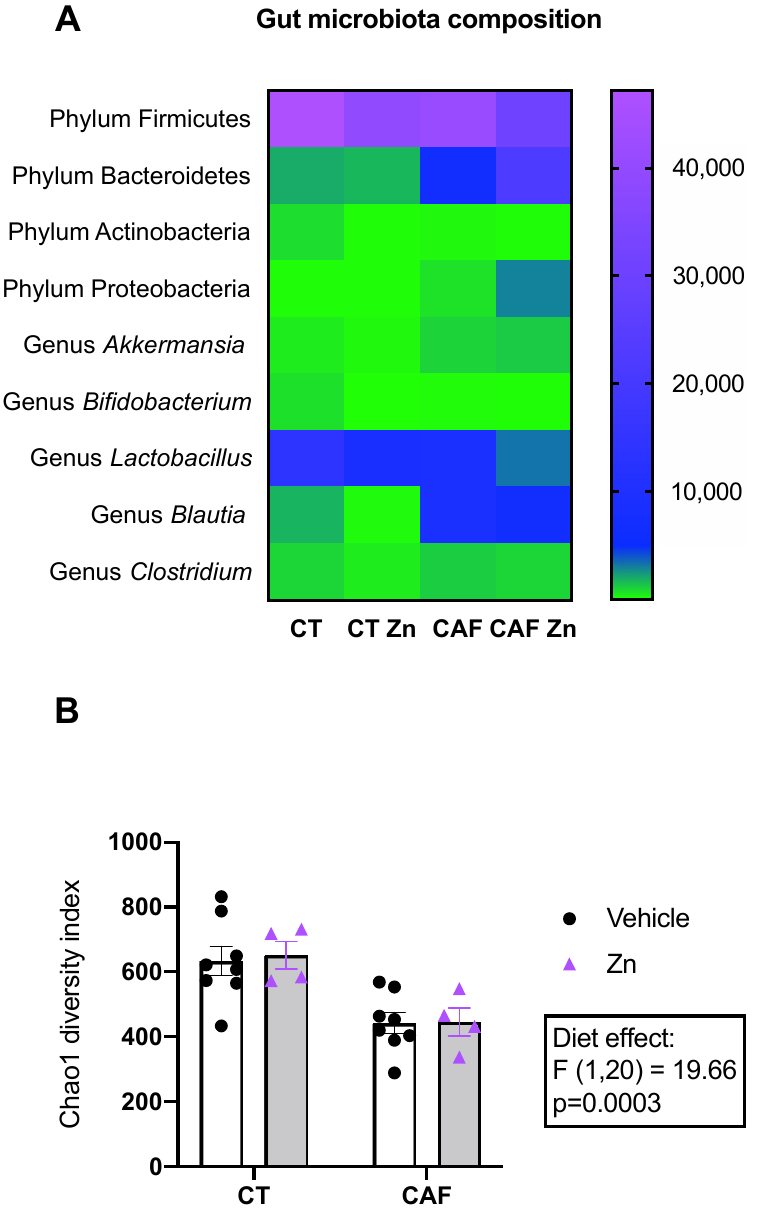
Figure 2. Composition of the gut microbiota of control (CT) and cafeteria diet (CAF)-fed animals. ( A ) Heatmap shows the phylum and genera levels of the main bacterial community found in the fecal samples of the intestinal colon. The range of colors, from green to lilac, indicates the abundance of each phylum or genera per group. ( B ) Chao1 diversity index. The text box indicates significant differences shown by two-way ANOVA regarding the effects of the diet (CT and CT + Zn vs. CAF and CAF + Zn). n = 4–8 animals/group.